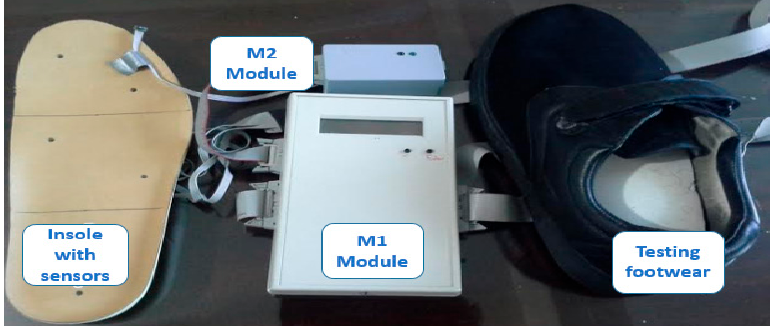
Figure 6. Prototype of the portable system for monitoring the microclimate in the interface of foot, footwear, and insole with sensors.